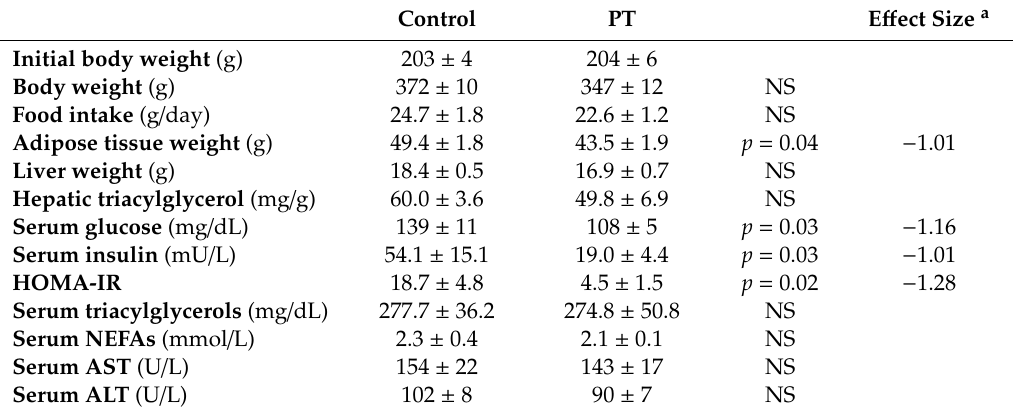
Figure 1. Histological study in liver from fa / fa Zucker rats either treated or not with pterostilbene (30 mg / kg body weight / day) for six weeks. Hematoxylin and eosin staining of liver tissue × 40. Table 2. General parameters from obese Zucker rats treated or not with pterostilbene (30 mg / kg body weight / day) for six weeks.